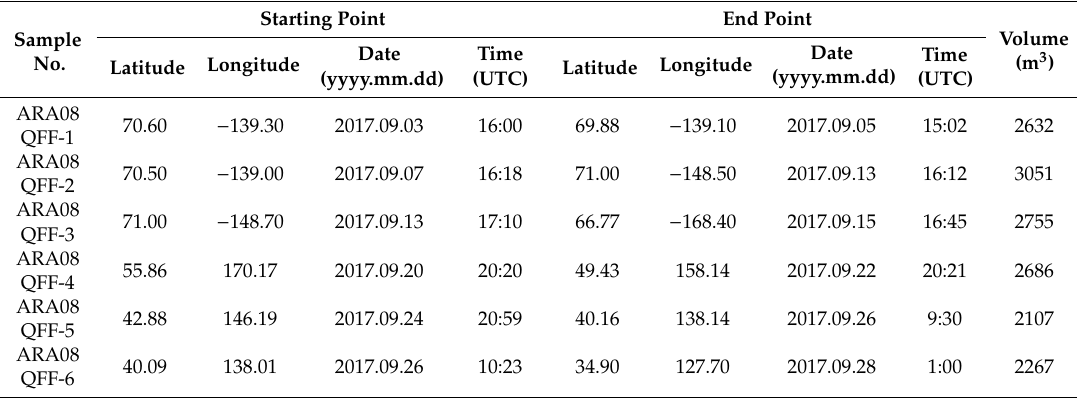
Table 1. Information on marine aerosol